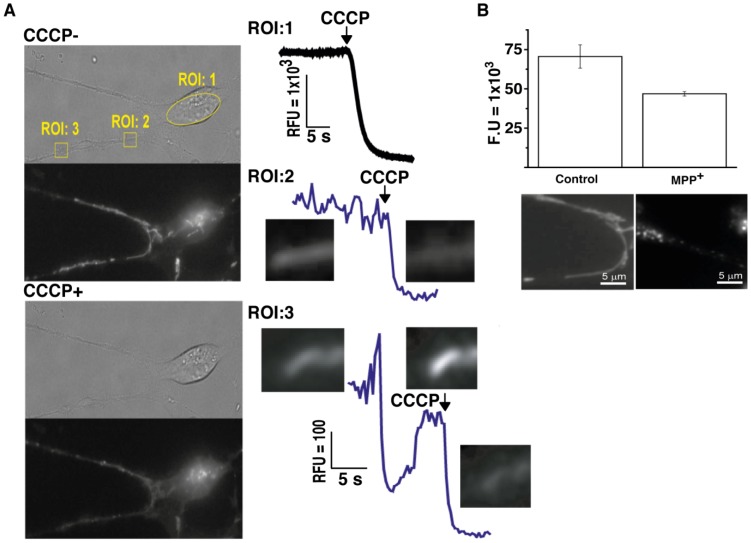
Measurements of mitochondrial membrane potentials and their sensitivity to MPP+.(A) Differentiated human neuronal cultures were loaded with mitochondrial membrane indicator TMRM. Changes in fluorescence were measured before (left upper) and after (left lower) application of the membrane potential uncoupler, CCCP. Right panels show quantification of fluorescence changes obtained from the 3 regions of interest marked in the left panels. Induced and spontaneous fluctuations in membrane potential were observed in some cells and changes could be detected at the level of a single mitochondrion (ROI 3). (B) Upper graph represents mean mitochondrial resting potential measured from cell bodies and the effect of exposure to the dopaminergic neuron toxin MPP+ for 24 h. Mean resting fluorescence intensity was significantly lower after MPP+ treatment (control, F.U. 68.8±13.4×103 and 40 µM MPP+, F.U. 43.6±2.9×103, t <0.05, n >40). Lower panels indicate mitochondrial morphological changes following MPP+ treatment.